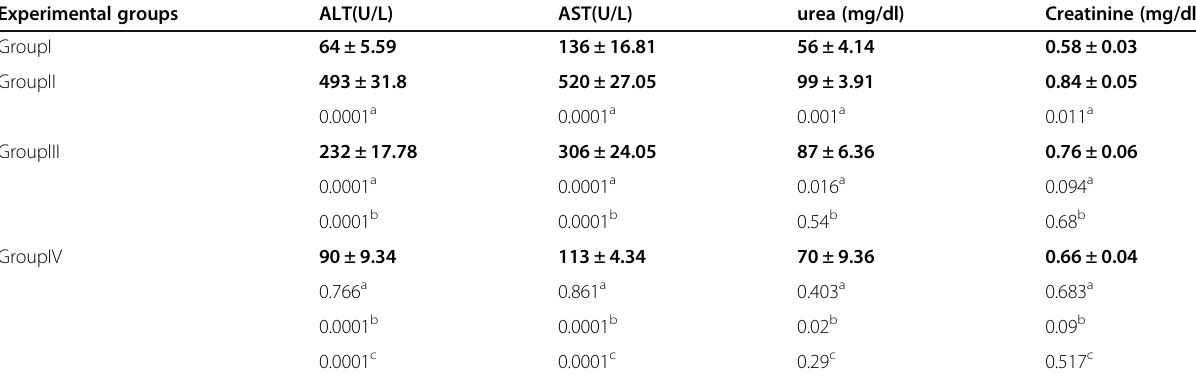
Table 2 The effect of AuNPs on the activity of hepatic and kidney enzymes in different experimental groups Experimental